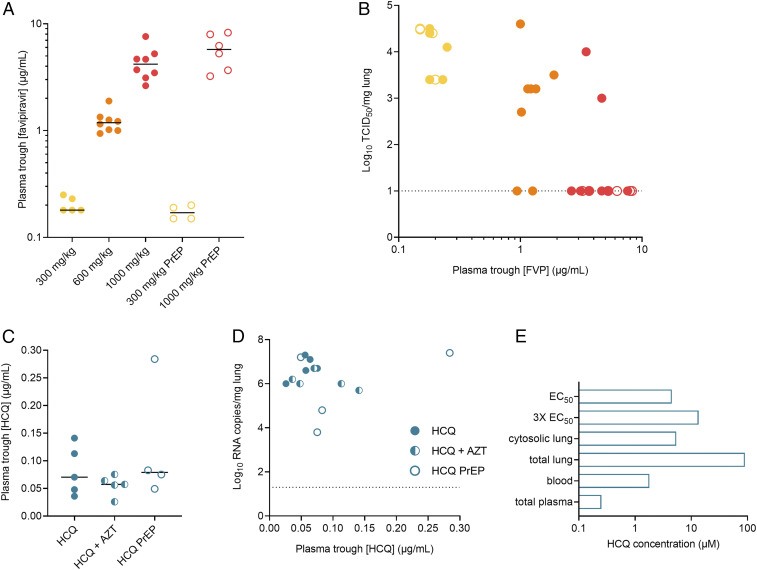
Pharmacokinetics of favipiravir and HCQ in infected and sentinel hamsters. (A) Individual plasma trough concentrations of favipiravir in hamsters treated with 300, 600, and 1,000 mg⋅kg−1⋅d−1 BID. The bars represent median values. PrEP, preexposure prophylaxis (in sentinel hamsters). (B) Infectious virus titers in lung tissue at day 4 pi to favipiravir (FVP) plasma trough concentrations of individual hamsters. (C) Individual plasma trough concentrations of HCQ in hamsters treated with HCQ or HCQ and azithromycin (AZT) (n = 14). The bars represent median values. (D) Viral RNA levels in lung tissue at day 4 pi to HCQ plasma trough concentrations of individual hamsters. (E) Summary of trough blood and tissue levels of HCQ in hamsters dosed with 50 mg/kg HCQ sulfate and comparison with in vitro EC50 values.